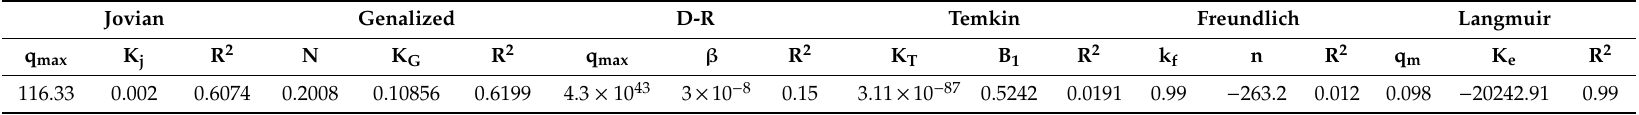
Table 1. Constant coe ffi cient of